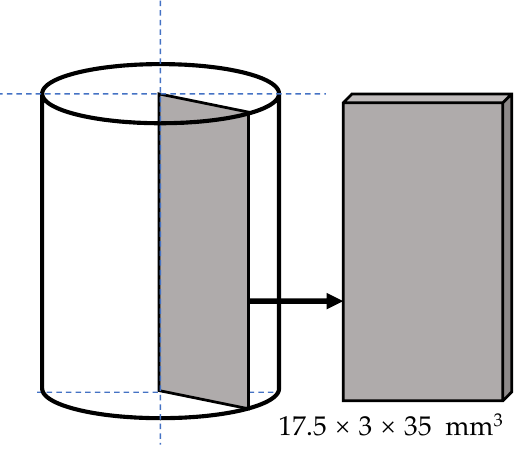
Figure 1. Schematic illustrations of ( a ) the thermal traces of the samples and ( b ) the high-frequency induction furnace: 1. silica crucible, 2. magnesia lining, 3. induction coil, 4. vacuum meter, 5. ther-